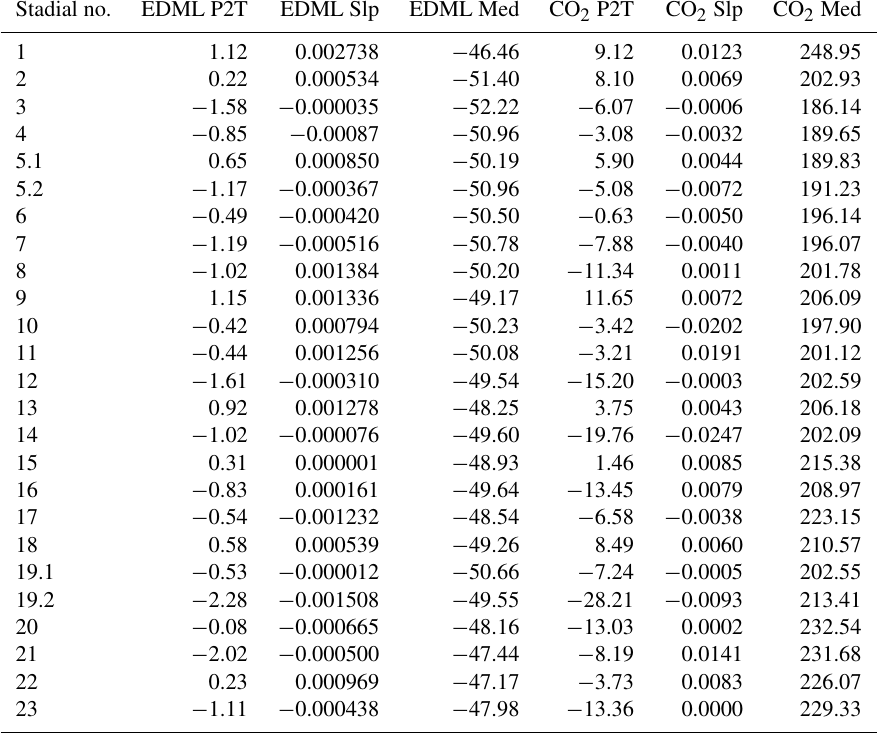
Table 3. Metric measurements for Antarctic records by stadial number. Abbreviations for records are given by EDML: EDML δ 18 O and compiled Antarctic CO 2 : CO 2 , and abbreviations for metrics are given by P2T: peak-to-trough, Slp: stadial slope, and Med: median. Stadial no.